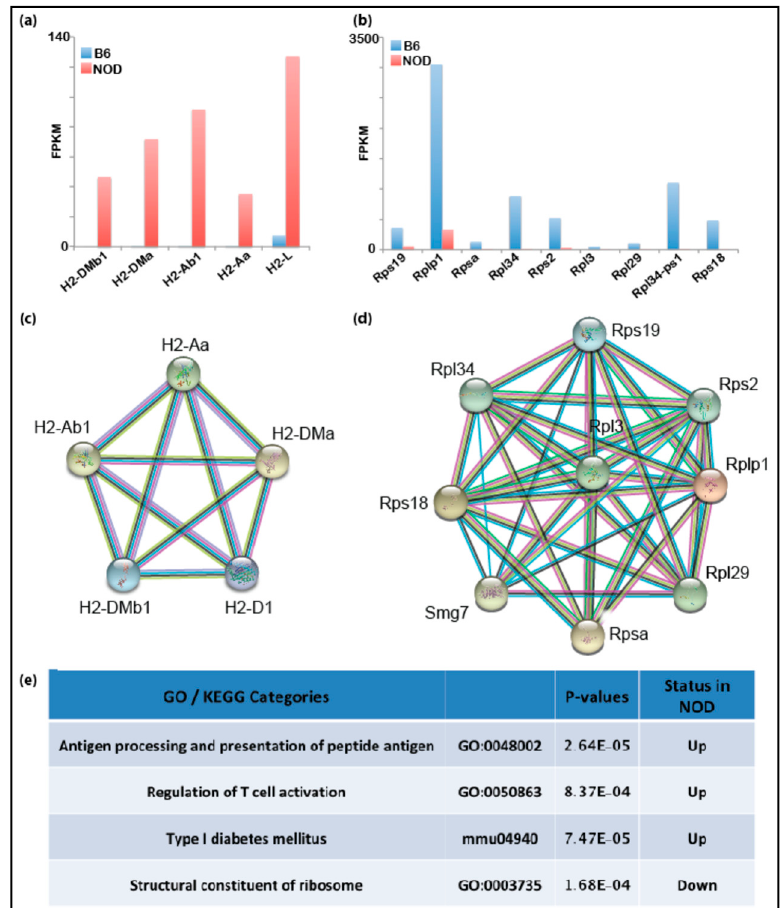
Figure 3. Transcriptomic analyses of NOD and pre-implantation B6 blastocysts: bar graphs show that genes in the Idd1 region that are ( a ) up-regulated in NOD blastocysts or ( b ) in B6 blastocysts. Functional protein association network analysis by STRING shows Idd regions that interact in ( c ) NOD blastocysts and ( d ) B6 blastocysts. ( e ) Gene set enrichment analysis shows that immune-related genes are up-regulated in NOD blastocysts.